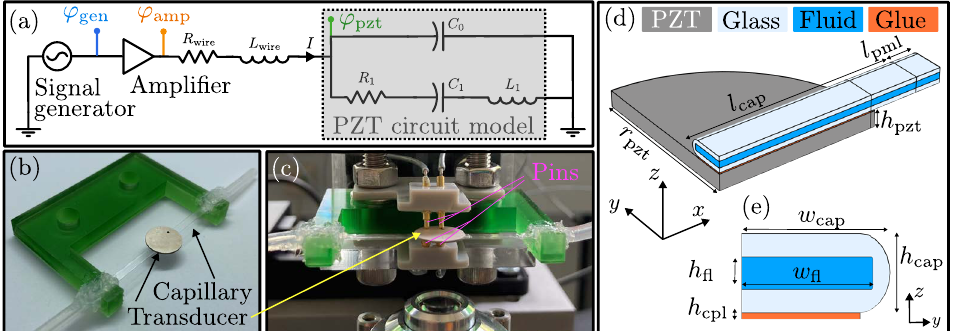
Figure 1. ( a ) A schematic overview of the electrical circuit driving the transducer. The transducer, represented by the BVD-model with a resistor R 1 , an inductor L 1 , and two capacitors C 0 and C 1 , is coupled in series with the parasitic wire resistance and inductance. ( b ) A disk-shaped piezoelectric transducer is glued to a long, straight glass capillary tube. The tube is connected to a 3D-printed sample holder (green), and inlet/outlet tubing is glued to the ends of the tube. ( c ) The acoustofluidic device is mounted above the microscope lens and is electrically connected via two spring-loaded pins on each side of the transducer. ( d ) Using the symmetry planes x - z and y - z , only a quarter of the actual geometry needs to be simulated numerically. The different domains of the model are: PZT (gray), glass (light blue), water (dark-blue), and the thin glue layer (orange). The dimensions are r pzt = 5.02 mm, h pzt = 506 µm, w fl = 2060 µm, h fl = 200 µm, h cpl = 39 µm, w cap = 2324 µm, and h cap = 483 µm. In the simulation the reduced lengths are l cap = 6.44 mm and l pml = 839 µm. ( e ) The cross-section in the y - z -plane is showing the glass tube, the water, and the glue